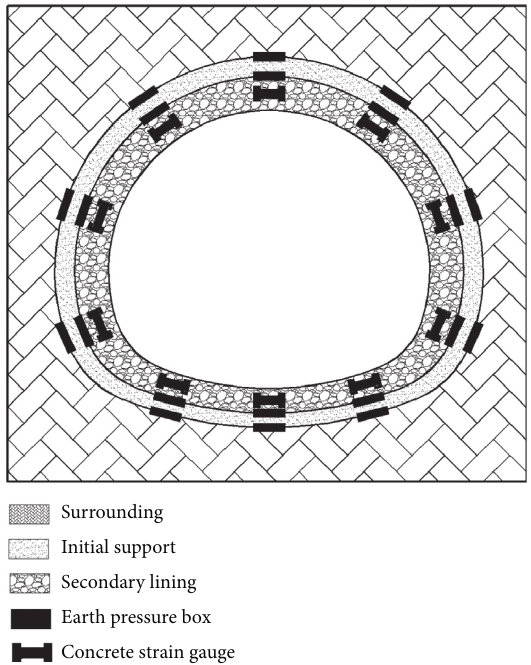
Figure 4: Schematic diagram of measuring point arrangement.